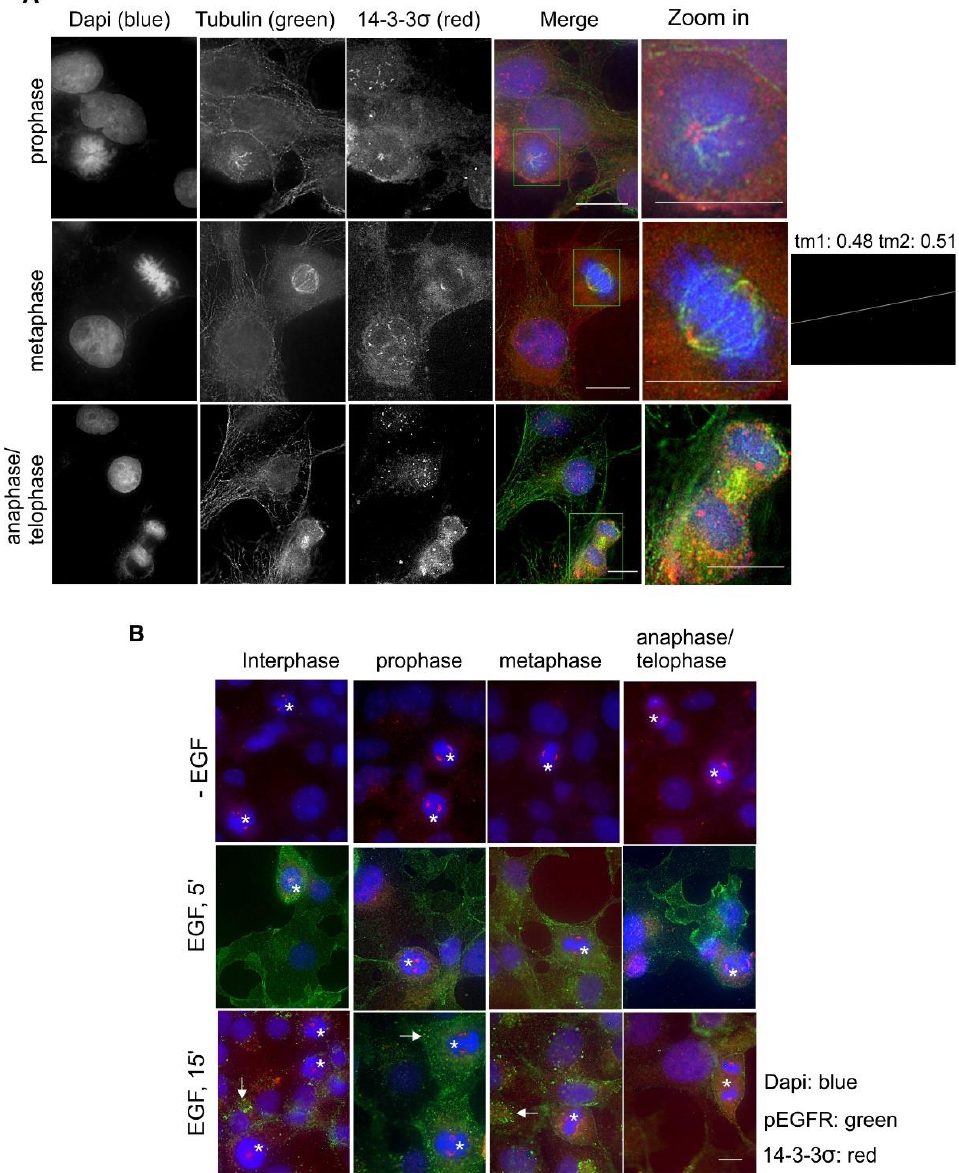
Figure 8. Subcellular localization of 14-3-3σ in Cos-7 cells by double indirect immunofluorescence. ( A ) Co-localization of 14-3-3σ (red) and tubulin (green) during mitosis. The zoomed-in areas were used to calculate Mander’s coefficients. ( B ) Subcellular localization of 14-3-3σ during the cell cycle and in response to EGF. With or without EGF stimulation, 14-3-3σ (red) and pEGFR (green) were revealed by double indirect immunofluorescence. Mitotic cells are labeled by * and endosomes are marked by arrows. Scale bar = 10 μm.